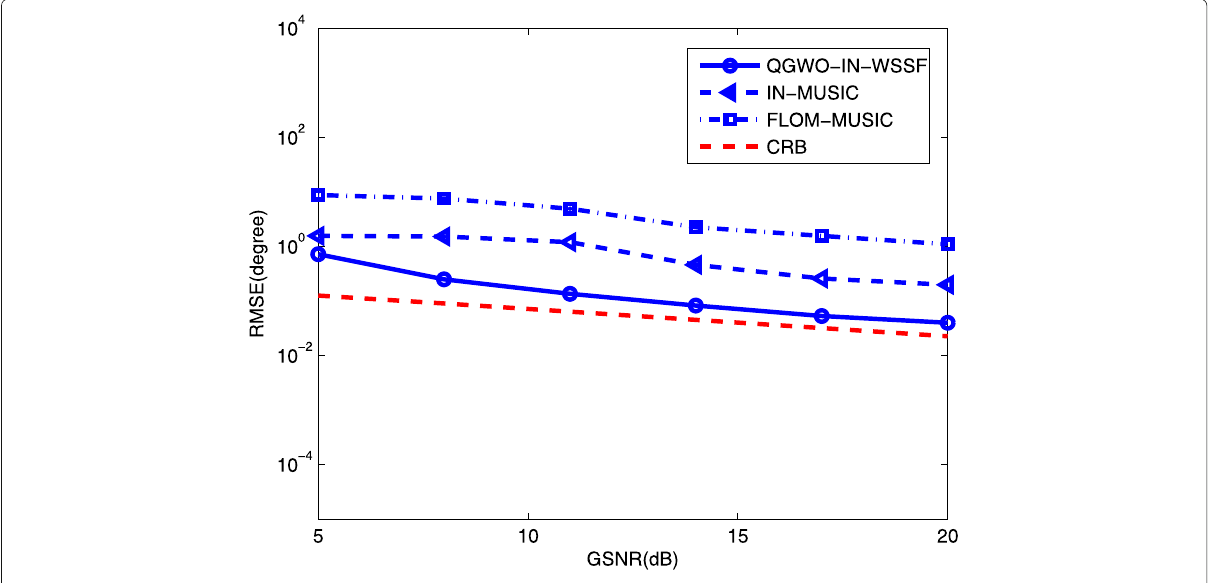
Fig. 4 RMSE curves and CRB versus GSNR for two independent sources with α =